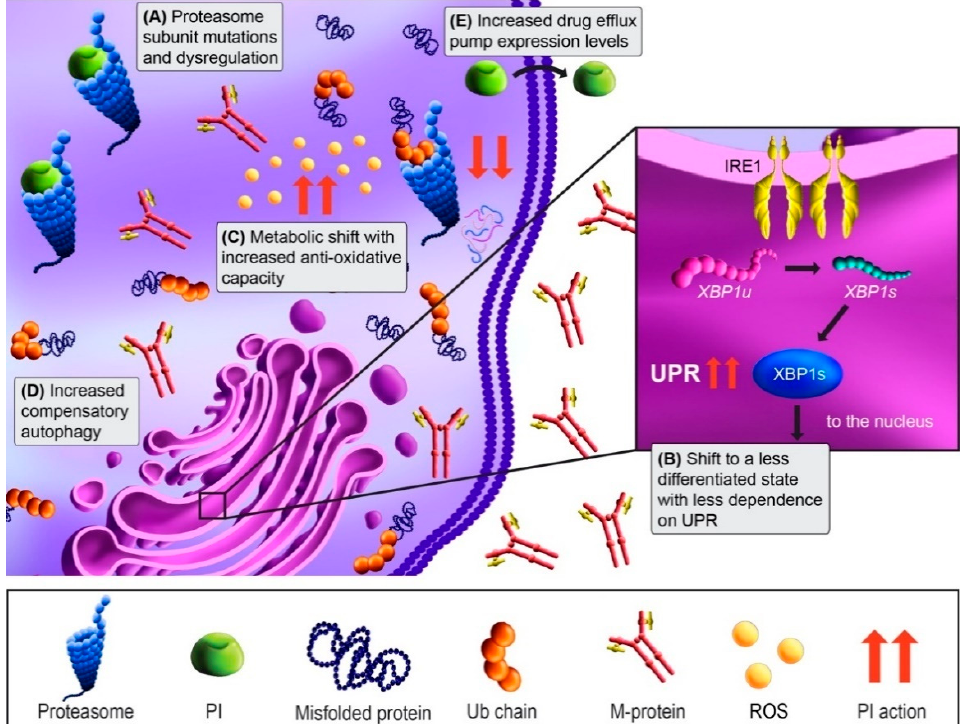
Figure 2. Proteasome inhibitor (PI) mechanism of action and resistance mechanisms. MM cells are dependent on the proteasome to degrade and recycle the high level of misfolded proteins that result from the production of M-protein. Treatment with PIs (green) blocks the degradation of ubiquitinated (Ub) proteins by binding either reversibly (bortezomib) or irreversibly (carfilzomib) to the proteasome. This blocks protein degradation, leading to the accumulation of misfolded proteins and activation of the unfolded protein response (UPR) and apoptosis (red arrows). ( A ) PI resistance can occur through mutations in proteasome catalytic subunits, or via dysregulation of subunit expression. ( B ) PI resistance may also occur in MM cells through a shift to a less differentiated phenotype that produces less M-protein and thus exhibit less dependence on the IRE1-Xbp1s UPR arm. ( C ) In addition, a shift in metabolic state can occur with PI resistance that more effectively neutralizes the cytotoxic reactive oxygen species (ROS) that are generated by UPR. ( D ) Autophagy upregulation is another compensatory adaptation that can maintain proteostasis when the proteasome is inhibited. ( E ) PI-resistant MM cells may adapt to PI treatment via upregulation of drug efflux pumps that extrude the drugs from the